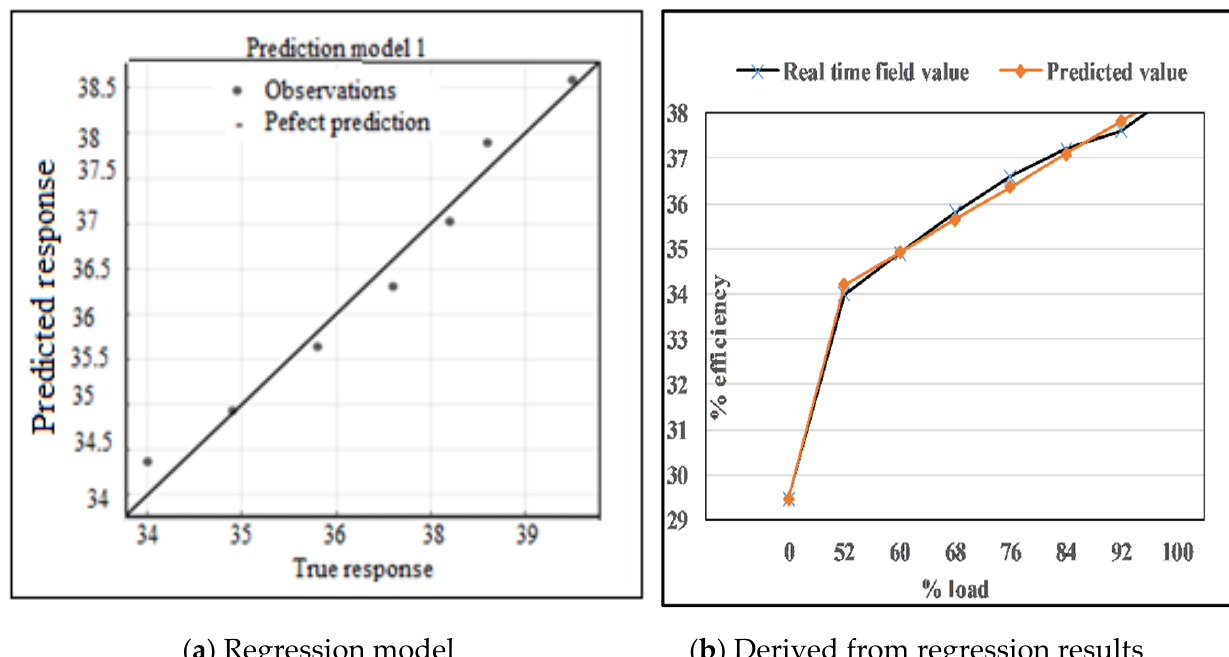
Figure 1. CGPP prediction results from regression learner.